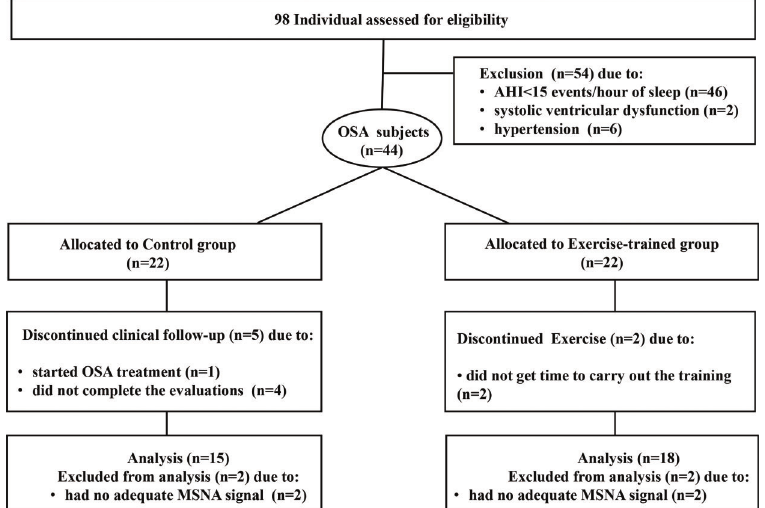
Figure 1 - Profile of a randomized clinical trial showing the progress of individuals throughout the trial. AHI = apnea-hypopnea index; OSA = obstructive sleep apnea; MSNA = muscle sympathetic nerve